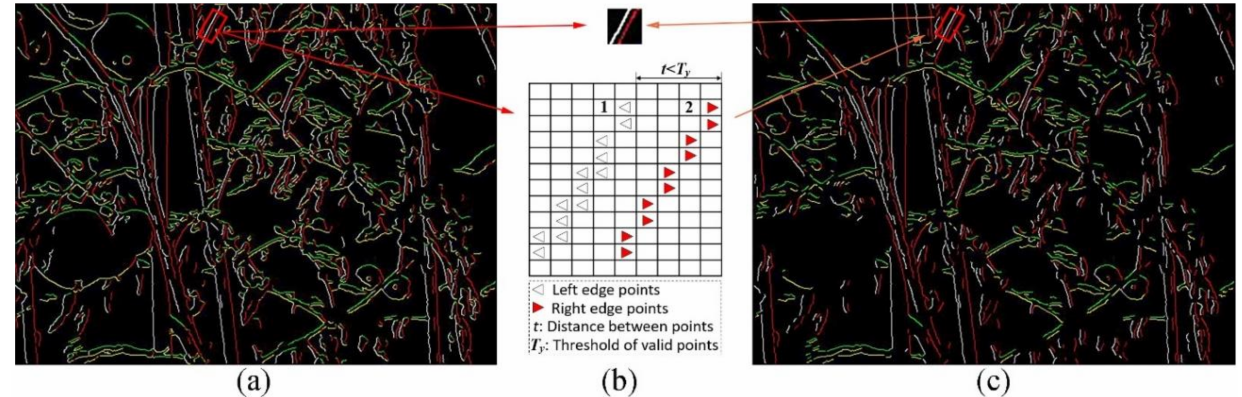
Figure A4. Principle of stem duality edge extraction algorithm: ( a ) four type edges; ( b ) principle; ( c ) stem duality